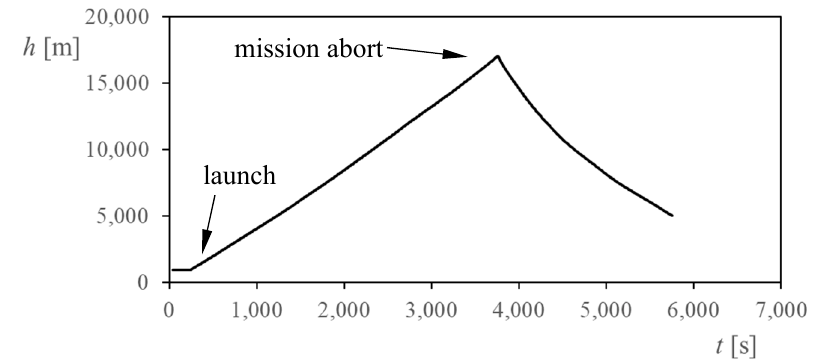
Figure 6. TASEC ‐ Lab flight profile. Altitude, h , in relation to the mission time, t . Figure 6. TASEC-Lab flight profile. Altitude, h , in relation to the mission time, t .